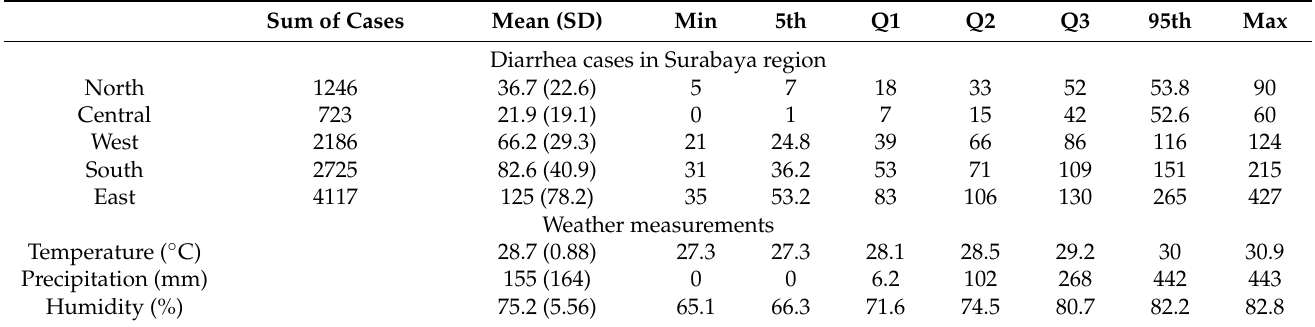
Table 1. Descriptive statistics of monthly averages of diarrhea cases and weather variables in Surabaya